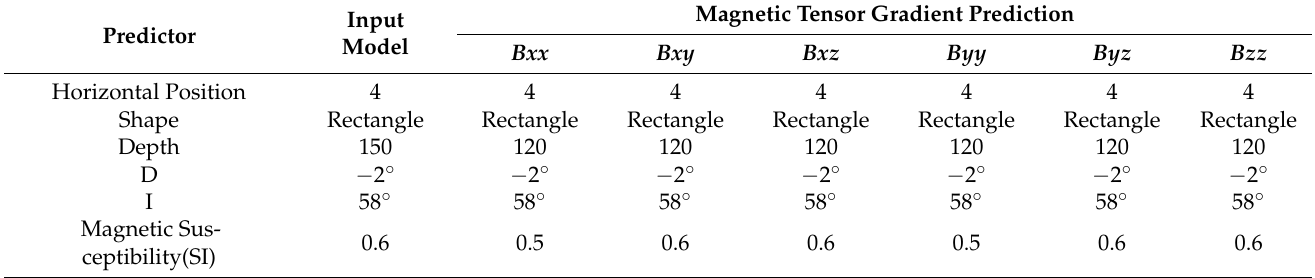
Table 4. The Rectangle model’s parameter settings and prediction results for each independent component.